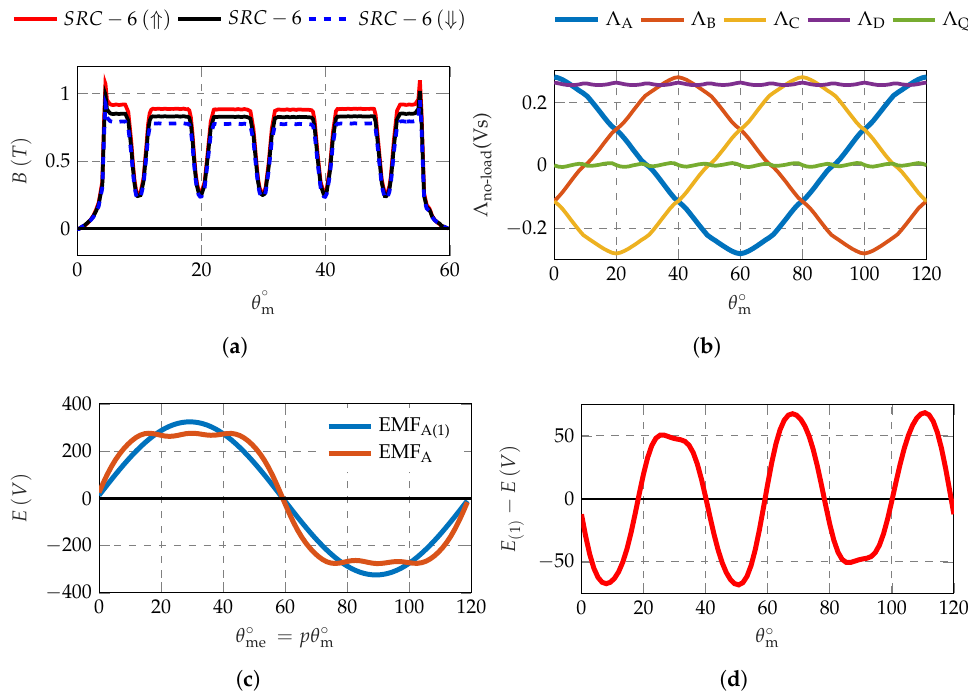
Figure 4. Flux density, electro-magnetic force and linkage flux of the SRC-6 machine. ( a ) Air gap flux density distribution versus rotor position. ( b ) No-load stator flux linkage versus rotor position. ( c ) Electro-magnetic force versus rotor position. ( d ) Difference between actual and main EMF harmonic versus rotor